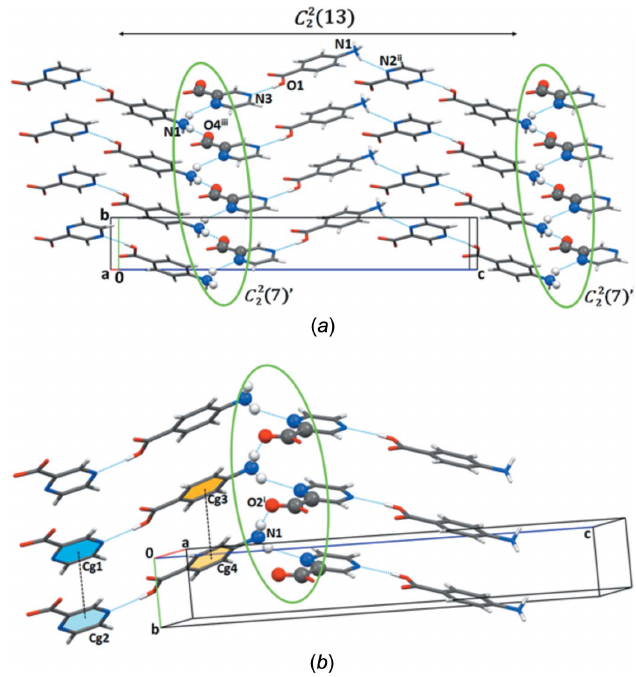
Figure 2 ( a ) The formation of zigzag C 2 (13) chains through O1—H1 (cid:2)(cid:2)(cid:2) N3 2